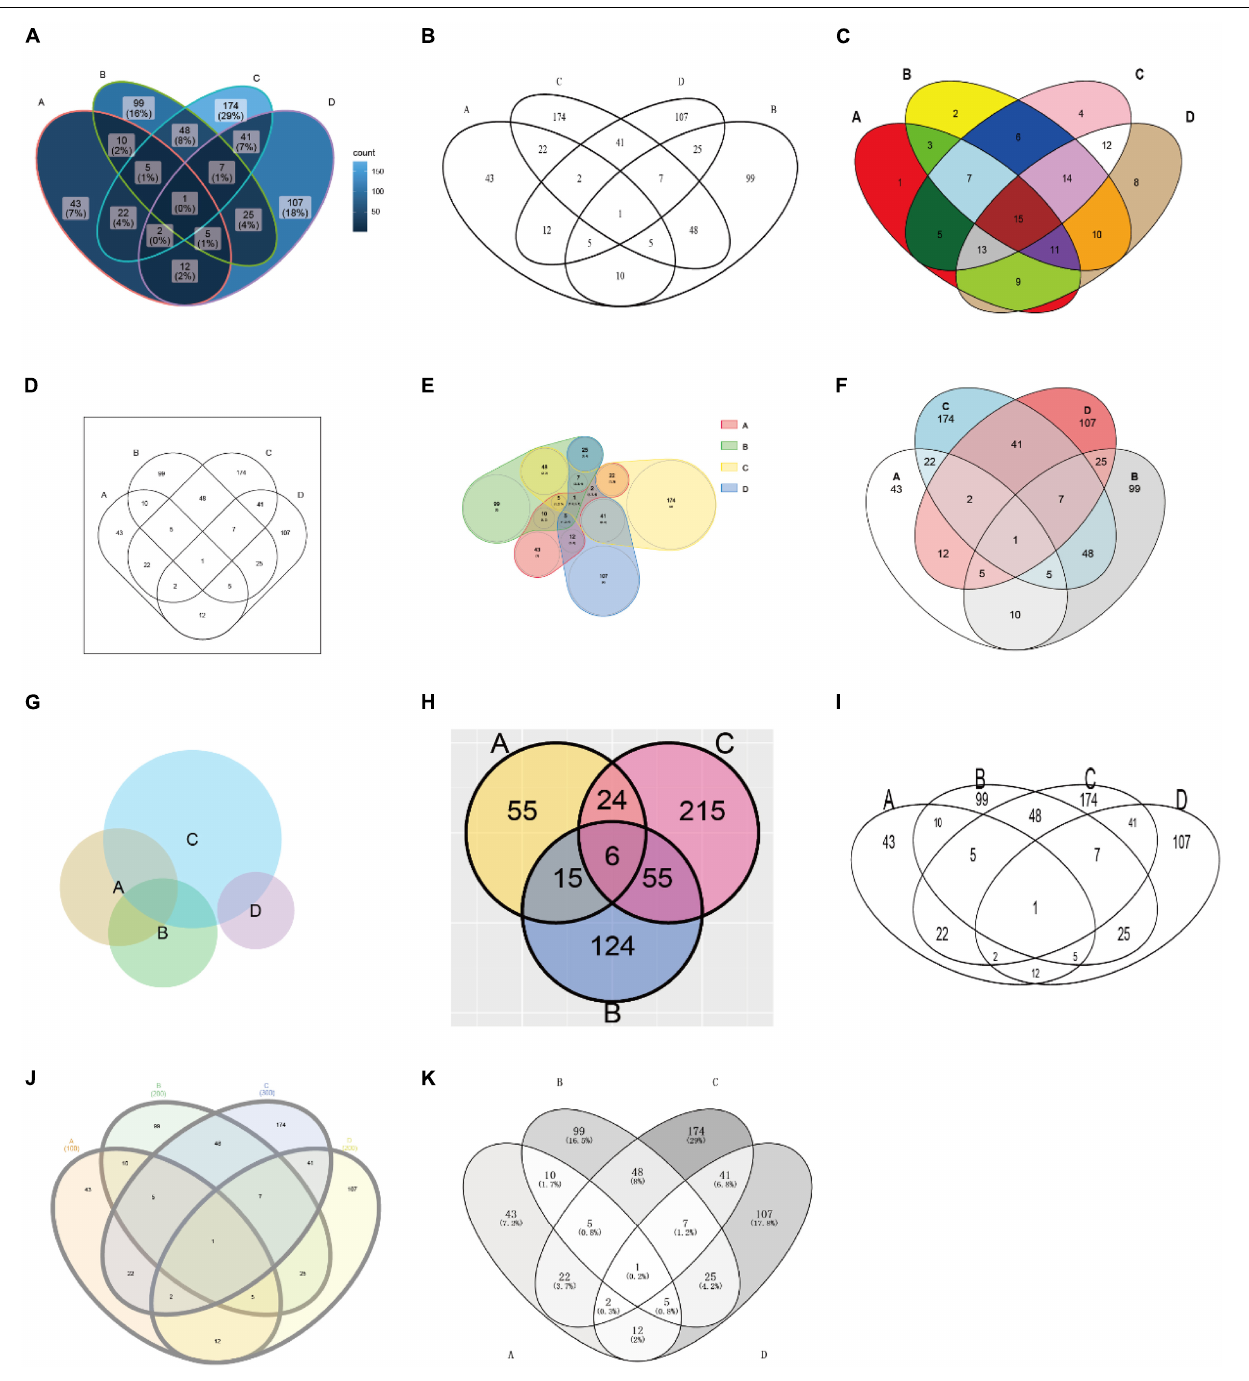
FIGURE 4 | Plots generated by the tools listed in Table 1 . The used tools are ggVennDiagram, VennDiagram, colorfulVennPlot, venn, nVennR, eulerr, RVenn, gplots, interactiVenn, and Venny (A–K) , respectively. Except for venn (D) , venneuler (G) , and RVenn (H) , all plots are generated with minimal configuration (using default parameters) and the same input data, which is a simulated four-set gene list. The input for venn is a named vector, while the input for venneuler is a qualified expression. Since RVenn do not support four-set Venn plots, only three sets of the gene list are used (H)